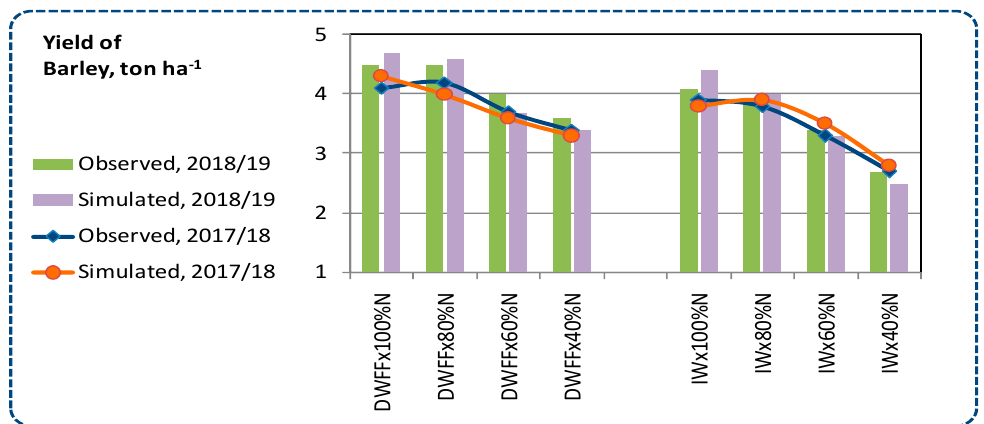
Figure 14. Effect of water quality and the fertigation rate of nitrogen on the observed and simulated yield of barley for the 2017/2018 and 2018/2019 seasons for all treatments: drainage water of fish farms(DWFF); fresh irrigation water (IW) and Nitrogen (N).